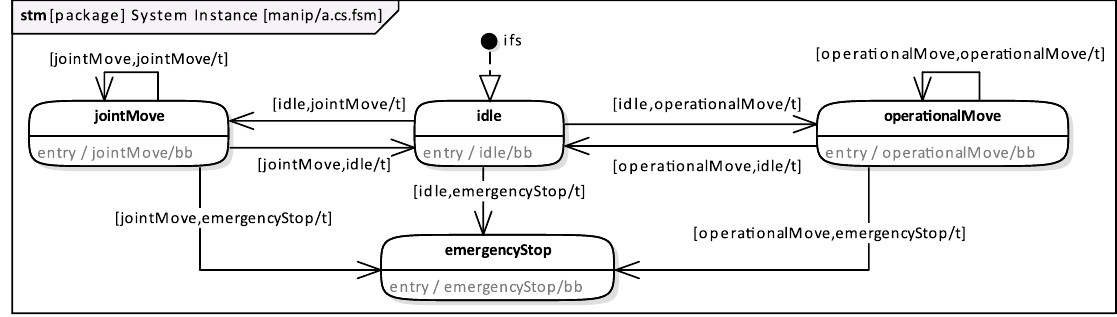
Figure 12. manip / a . cs . fsm definition. Conditions of transitions between FSM States are specified in Table